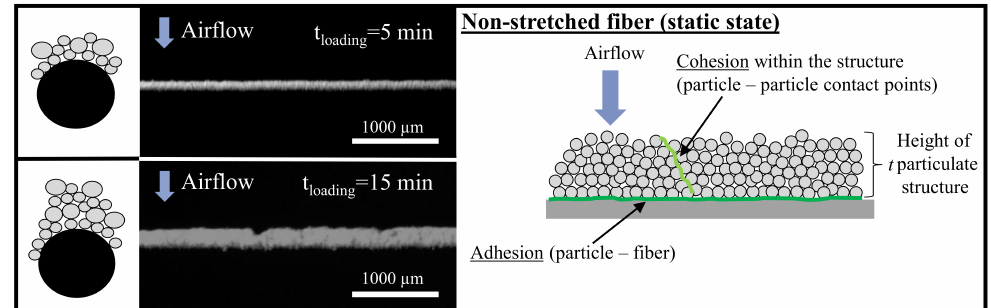
Figure 3. ( LEFT ): Images (in the side view) of the loaded fiber after 5min loading time (TOP) and after 15 min loading time (BOTTOM).Direction of airflow from the top to the bottom. Illumination from the front. ( RIGHT ): Schematic of the loaded fiber in the non-stretched state. Marked is the state of the interfacial layer and the condition of